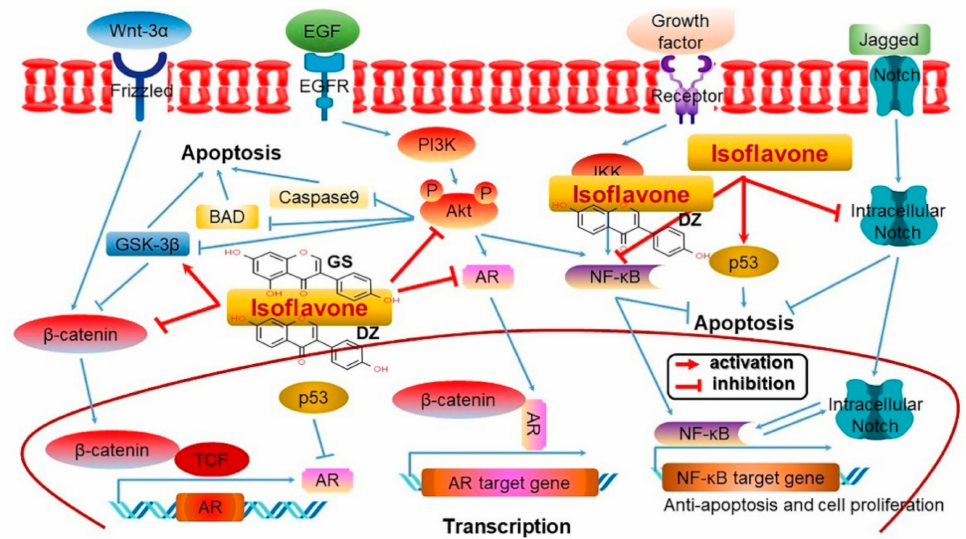
Figure 9. Cellular signaling mechanism associated with the activation of isoflavone-induced cancer cell apoptosis. Isoflavones activate glycogen synthase kinase 3 beta (GSK3 β ) and p53 associated with apoptosis. In contrast, they inhibit the expression of β -catenin, protein kinase B (Akt), andro- gen receptor (AR), nuclear factor kappa B (NF- κ B), and intracellular Notch, which regulate tumor cell proliferation. In various cancer cells, altered conformational changes of target proteins caused by endo/exogenous stimuli, including mutations and amplifications of genes, or other defects, affect cellular signal that modulate apoptotic cell death. NF- κ B, Akt, mitogen activated-protein kinase (MAPK), Wnt, Notch, p53, and AR pathways are commonly changed in various cancers. Among them, the NF- κ B signaling pathway plays crucial roles in regulating cell growth and dif- ferentiation, apoptosis, inflammation, stress response, and other physiological processes including diabetes. Several important molecules in the NF- κ B-mediated signaling pathway, such as NF- κ B, inhibitor of NF- κ B (I κ B), and I κ B kinase (IKK), regulate apoptotic signal transduction; however,